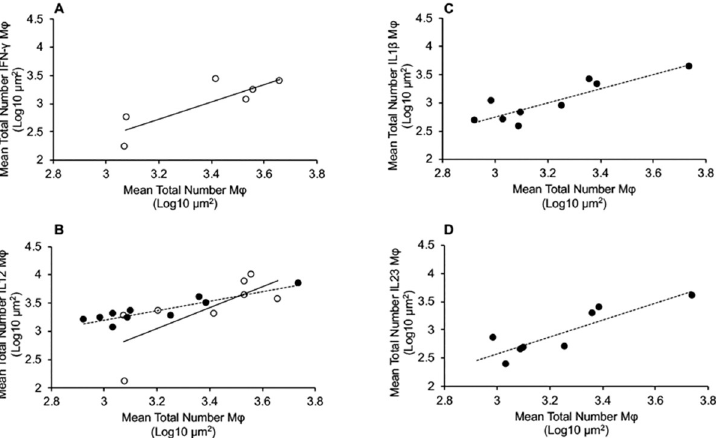
Fig 5. Pairwise Pearson correlations for total number of macrophages (M φ ) with host defense M φ phenotypes. ( A ) correlation between total M φ and number of IFN- γ + M φ for control cows; ( B ) correlation between total M φ and number of IL-12+ M φ for control cows ( � and solid line) and subclinical cows ( ● and dotted line); ( C ) correlation between total M φ and number of IL-1 β + M φ for subclinical cows; and ( D ) correlation between total M φ and number of IL-23+ M φ for subclinical